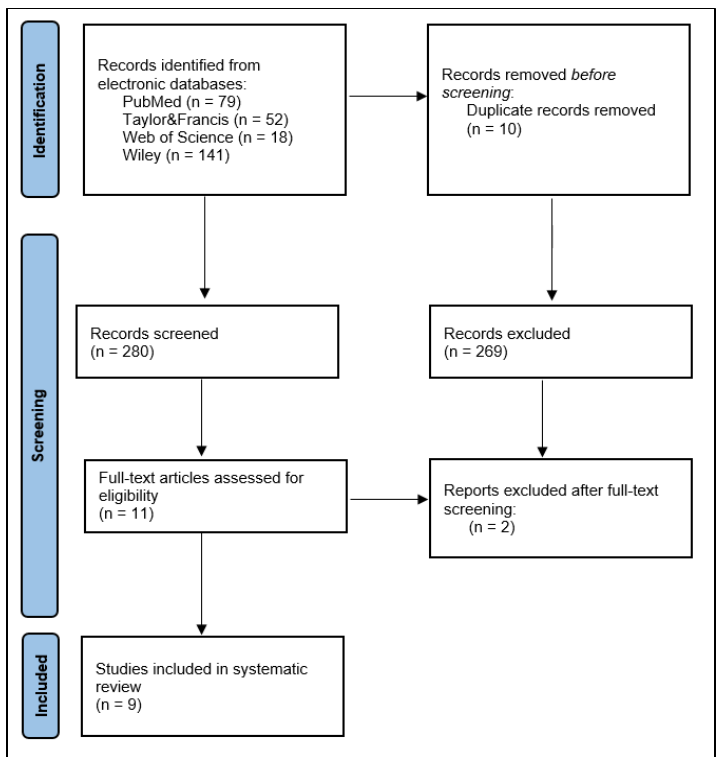
Figure 1. PRISMA flow diagram.